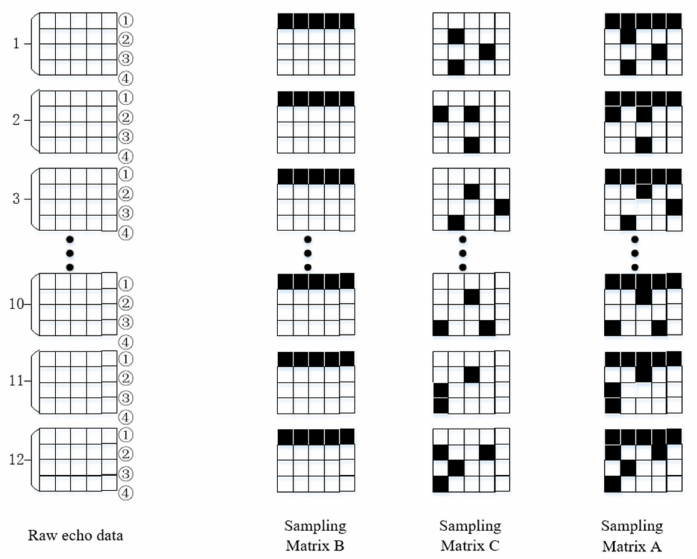
Figure 4. Schematic diagram of the three sampling matrices of the SFCWSAR approximate observa- tion